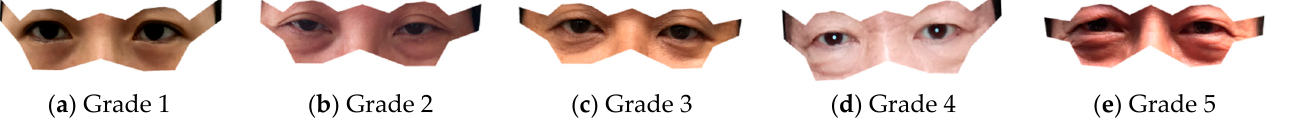
Figure 5. Examples of the five grades of eye wrinkles (regions are similar to Figure 2c).